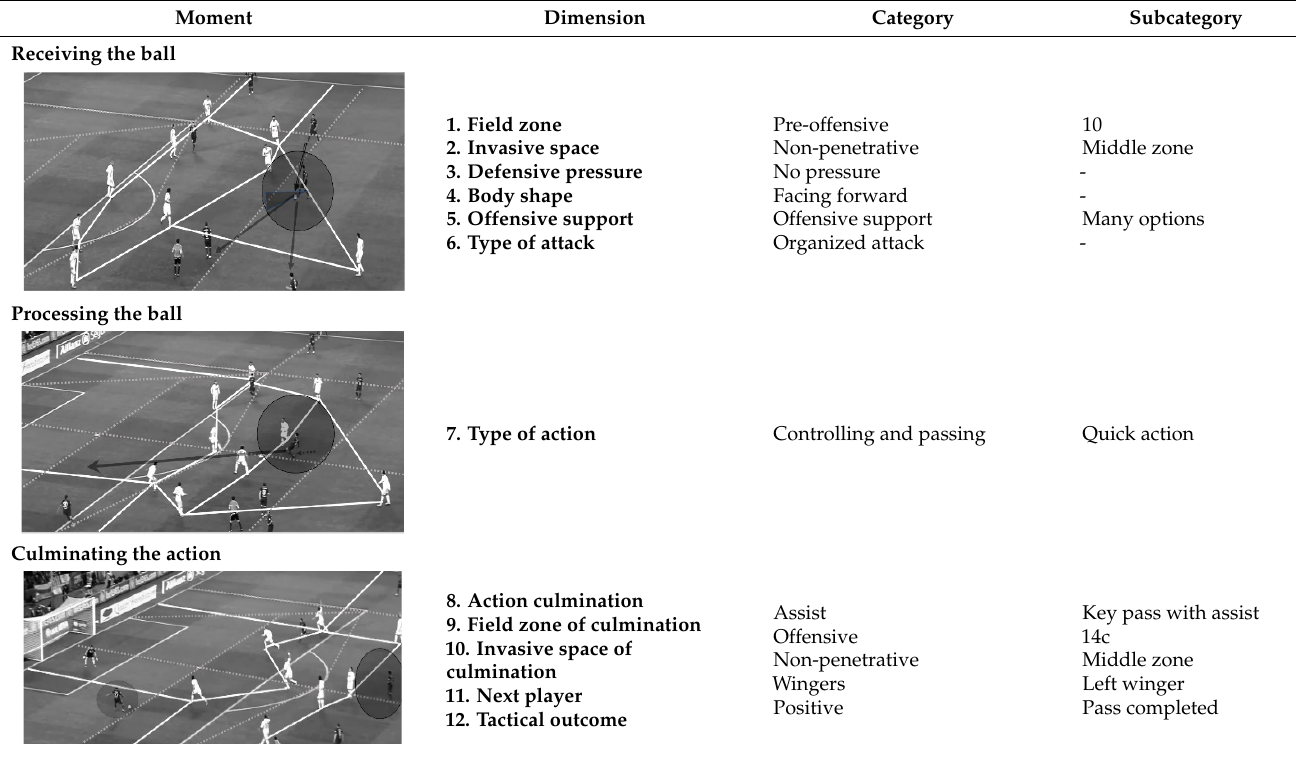
Table 5. Values of content validity (Aikens’s V) of the dimensions that form the INDISOC observa- tional